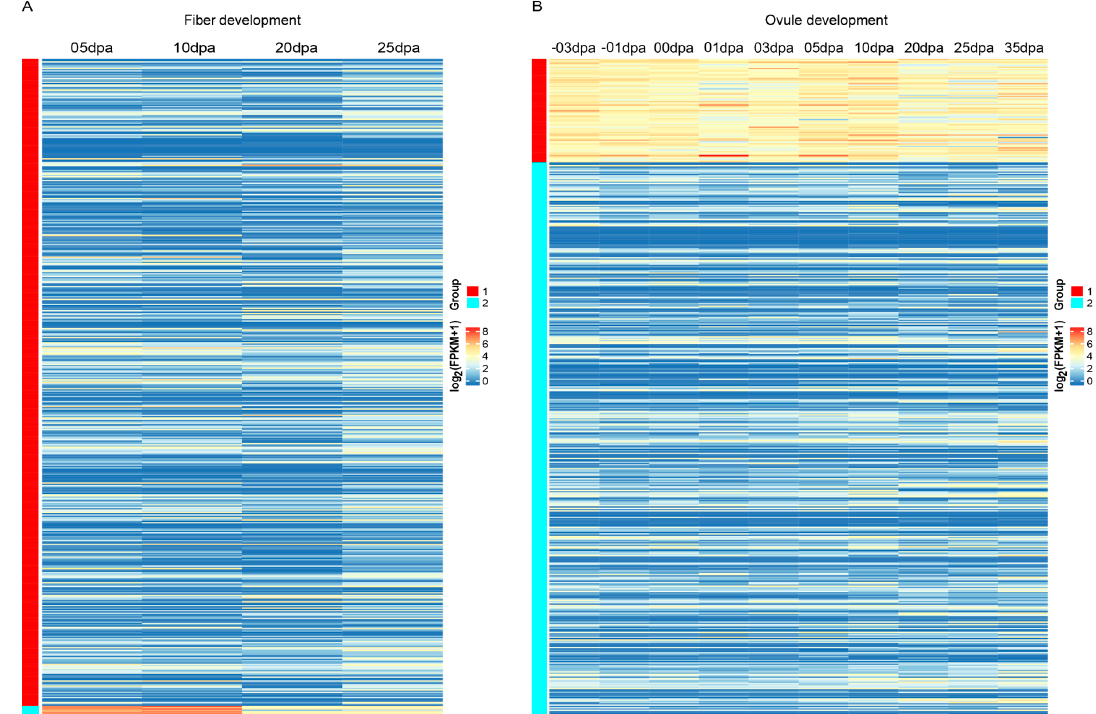
Figure 6. Expression patterns of G. hirsutum LRR-RLK genes in fiber and ovule development. Genes were clustered by the k -means method.